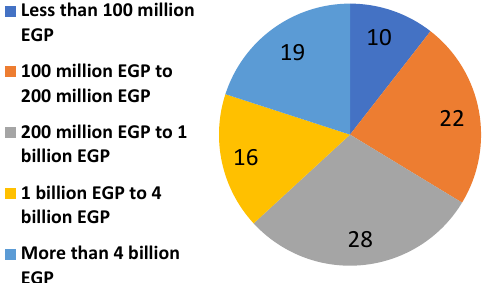
Figure 3. Number of the employees in the participants’ companies .